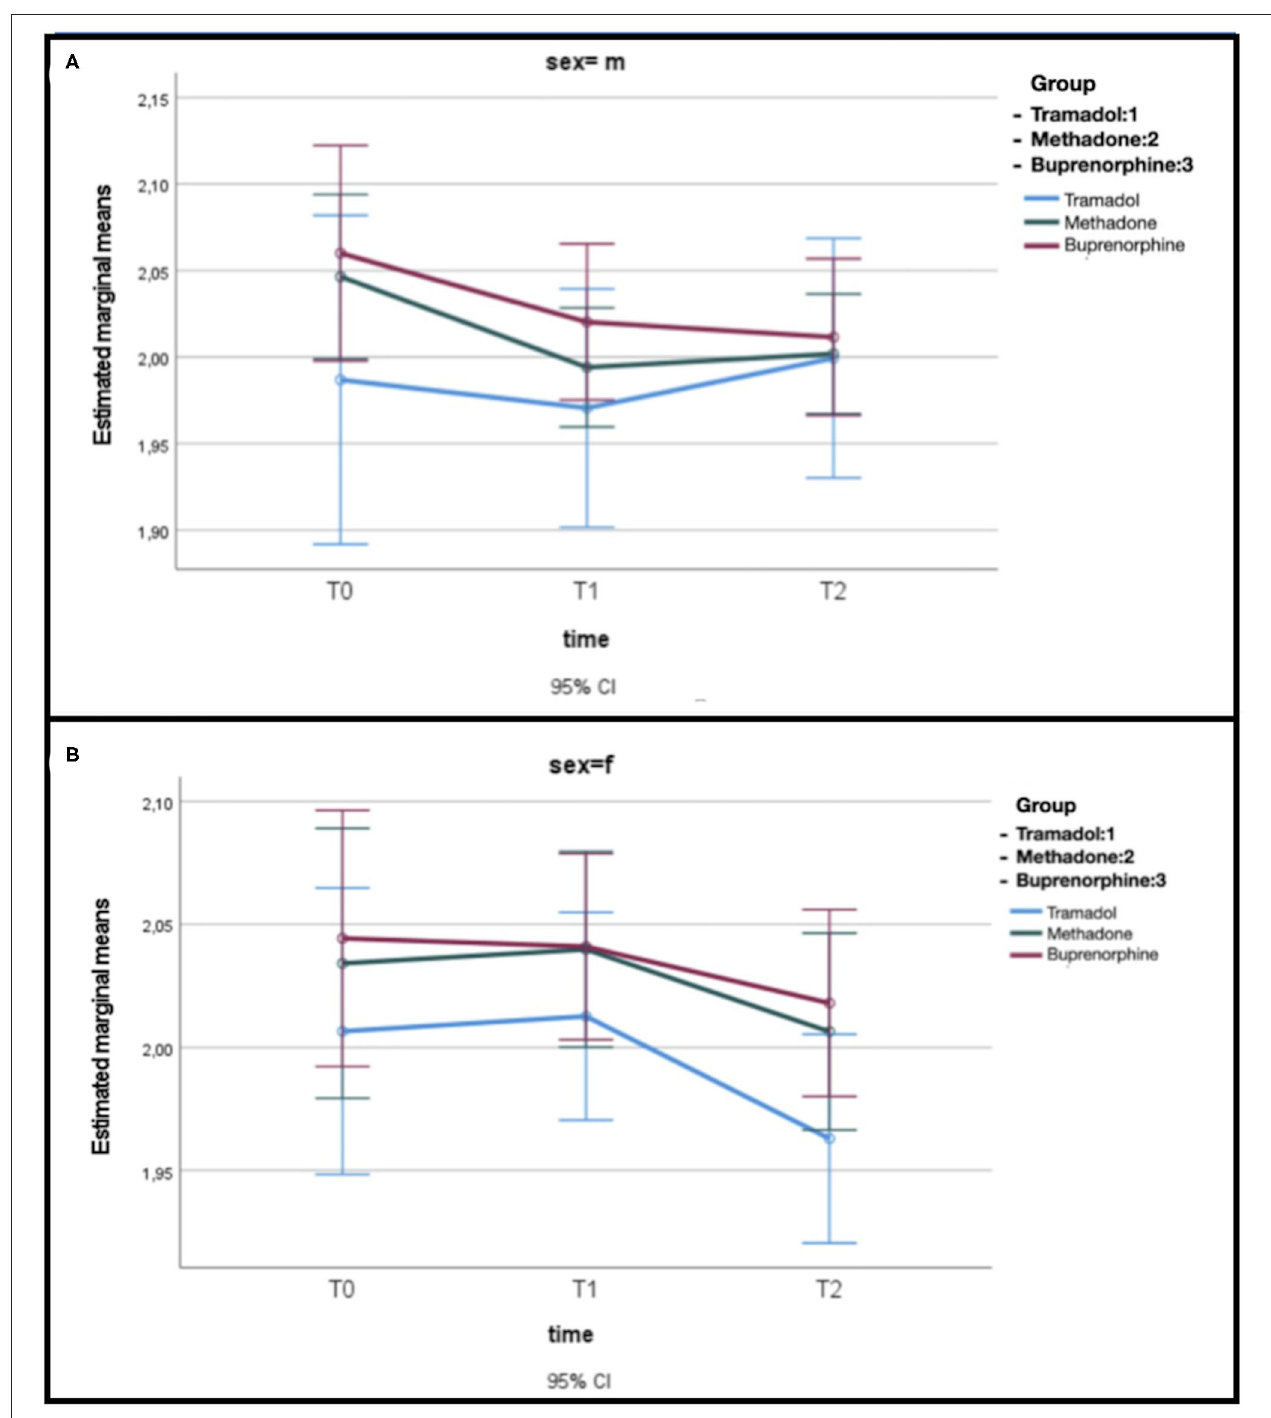
FIGURE 2 | (A) Estimated mean glucose levels related to opioid treatment in male dogs. (B) Estimated mean glucose levels related to opioid treatment in female dogs.